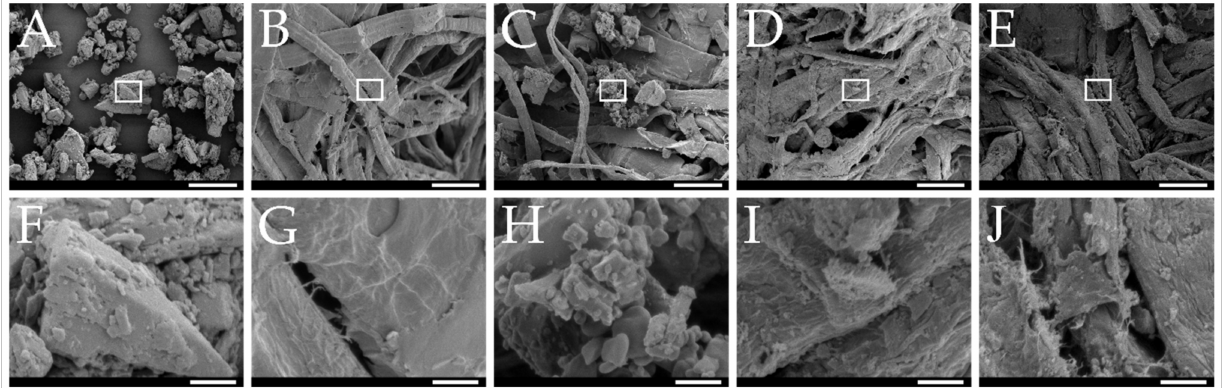
Figure 3. SEM micrographs of ( A ) pure curcumin, ( B ) unloaded paper granules, ( C ) physical mixture, ( D ) curcumin-loaded smartFilm granules, and ( E ) curcumin-loaded smartFilm tablets with the respective magnification ( F – J ) corresponding to the white square. Scale bars represent 60 µ m in ( A – E ) and 7 µ m in ( F – J